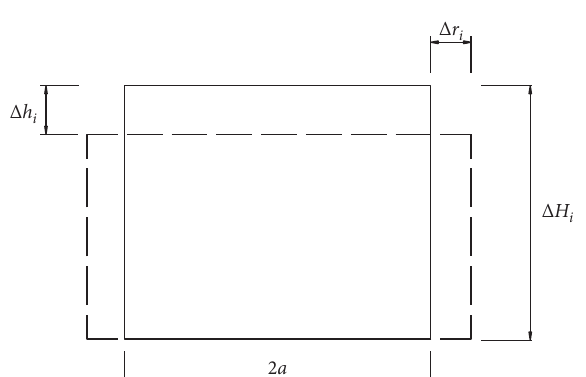
Figure 3: Deformation of the i- th microelement of